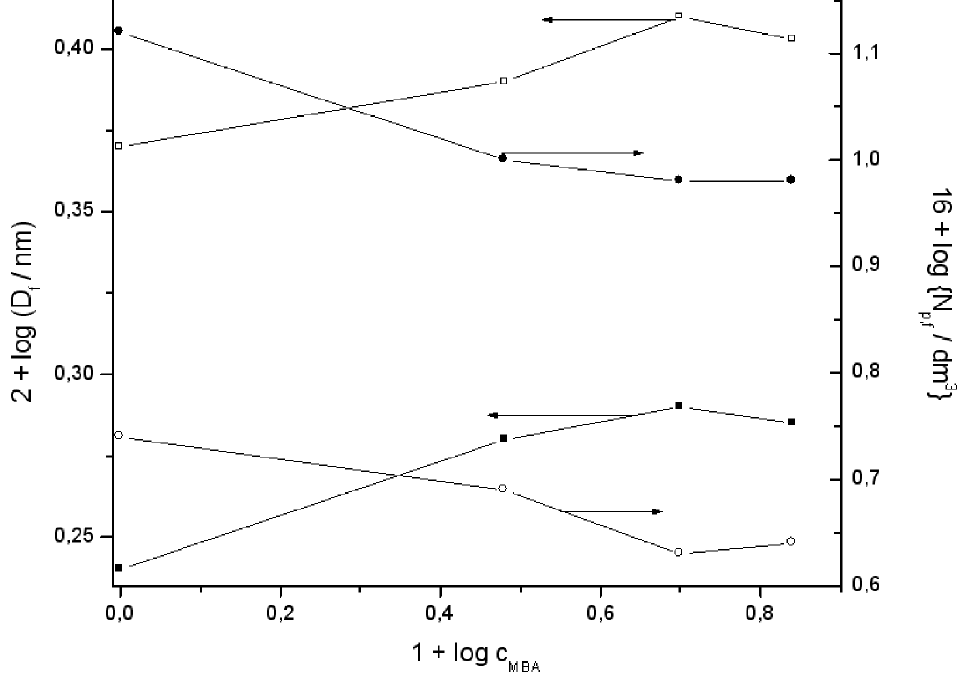
¥ , ¤ ) and the number of polymer particles (N f ; p;f ; MBA /(g/100 g CH))